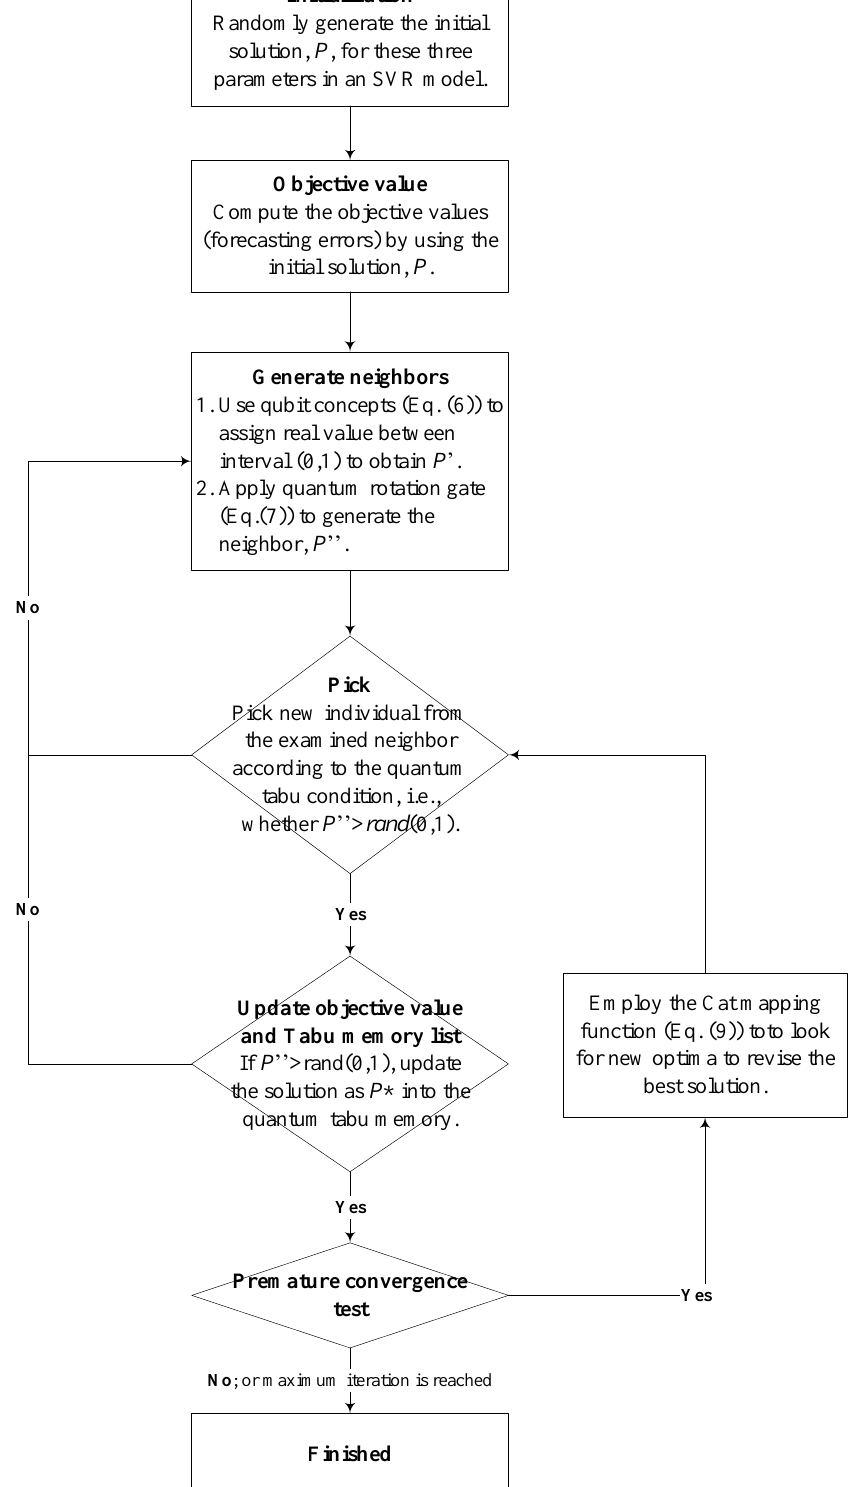
Figure 1. Quantum tabu search (QTS) algorithm flowchart.